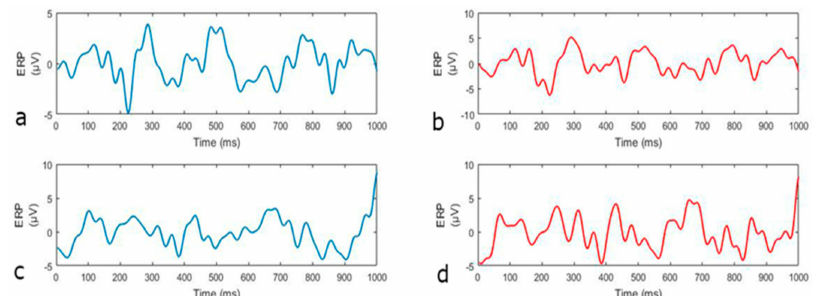
Figure 7. Average EEG of mismatch and standard trials. ( a ) Average in-ear EEG ERP responses from all mismatch trials. ( b ) Average T8 EEG from all mismatch trials. ( c ) Average in-ear EEG after standard beeps. ( d ) Average T8 EEG after standard